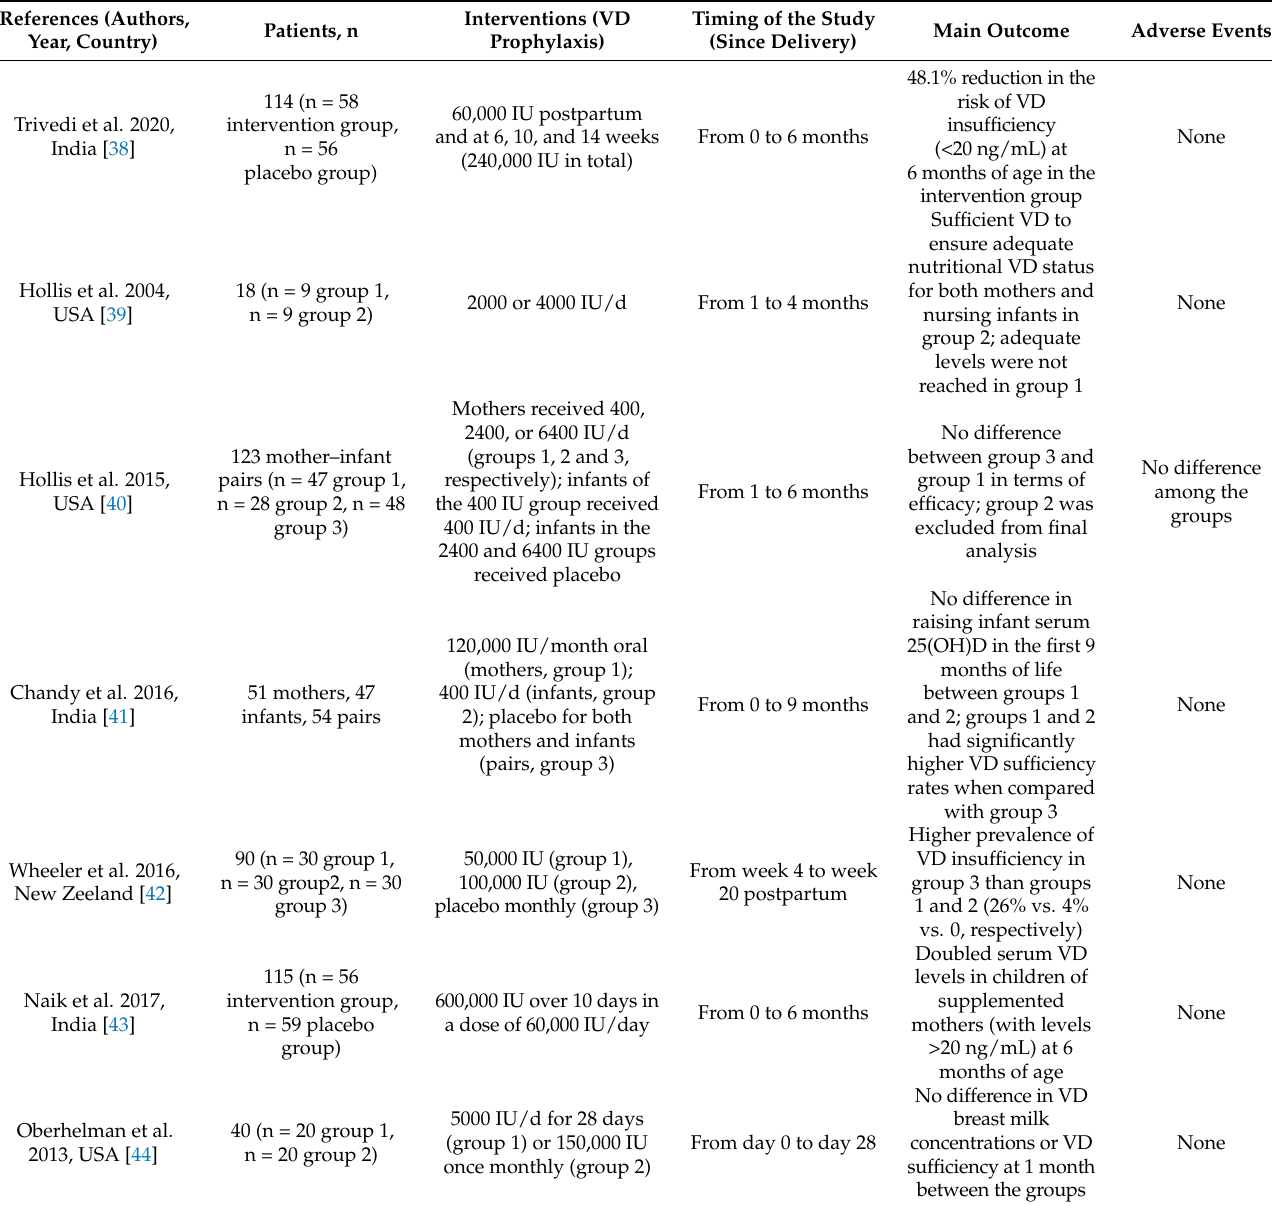
Table 2. Studies investigating Vitamin D supplementation for